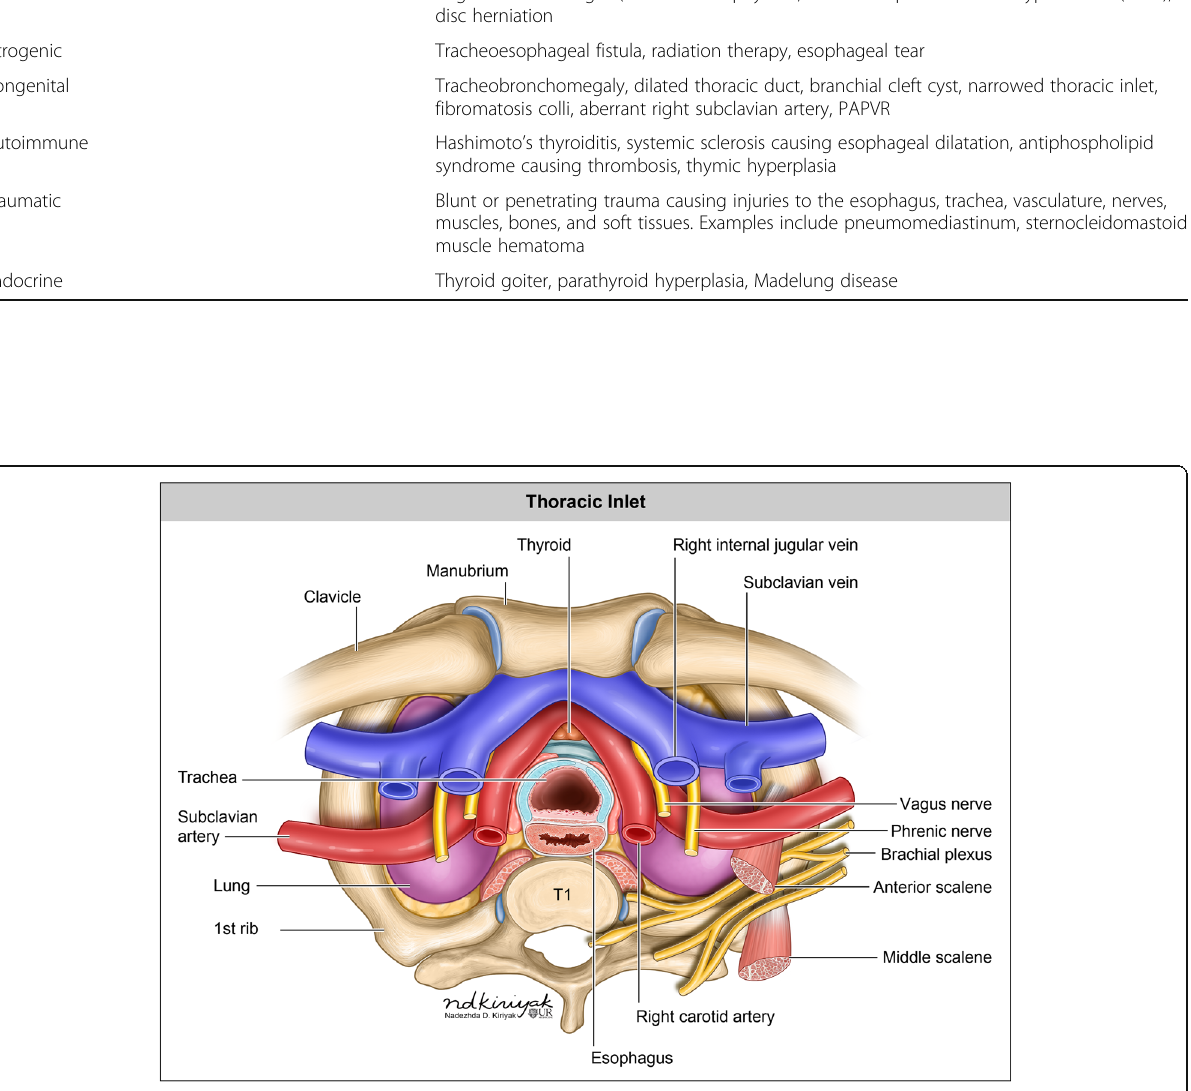
Fig. 1 Anatomy of the thoracic inlet. The trachea is commonly located anterior and right lateral to the esophagus. The aortic arch typically gives rise to three main branches: the brachiocephalic artery (also known as the innominate artery or brachiocephalic trunk) which divides into the right common carotid artery and right subclavian, the left common carotid artery, and the left subclavian artery. The subclavian veins join the internal jugular veins to form the brachiocephalic veins (also known as innominate veins), which empty into the superior vena cava (SVC). The brachial plexus is comprised of nerve roots from cervical level 5 to thoracic level 1 and provides motor and sensory innervation to the shoulder and arm [1]. The phrenic nerve arises from cervical levels 3 – 5, running along the anterior surface of the anterior scalene muscle in the neck and enter the thorax posterior to the subclavian vein, providing innervation for the diaphragm. The bilateral vagus nerves are rarely directly discernible, even with high-resolution imaging. Their location, however, may be inferred by recognizing anatomic landmarks of their expected course and should be kept in mind during interpretation [1]. The thyroid isthmus lies just above the level of the thoracic inlet in the midline. The right and left lobes of the thyroid may extend inferiorly through the thoracic inlet into the mediastinum/substernal space